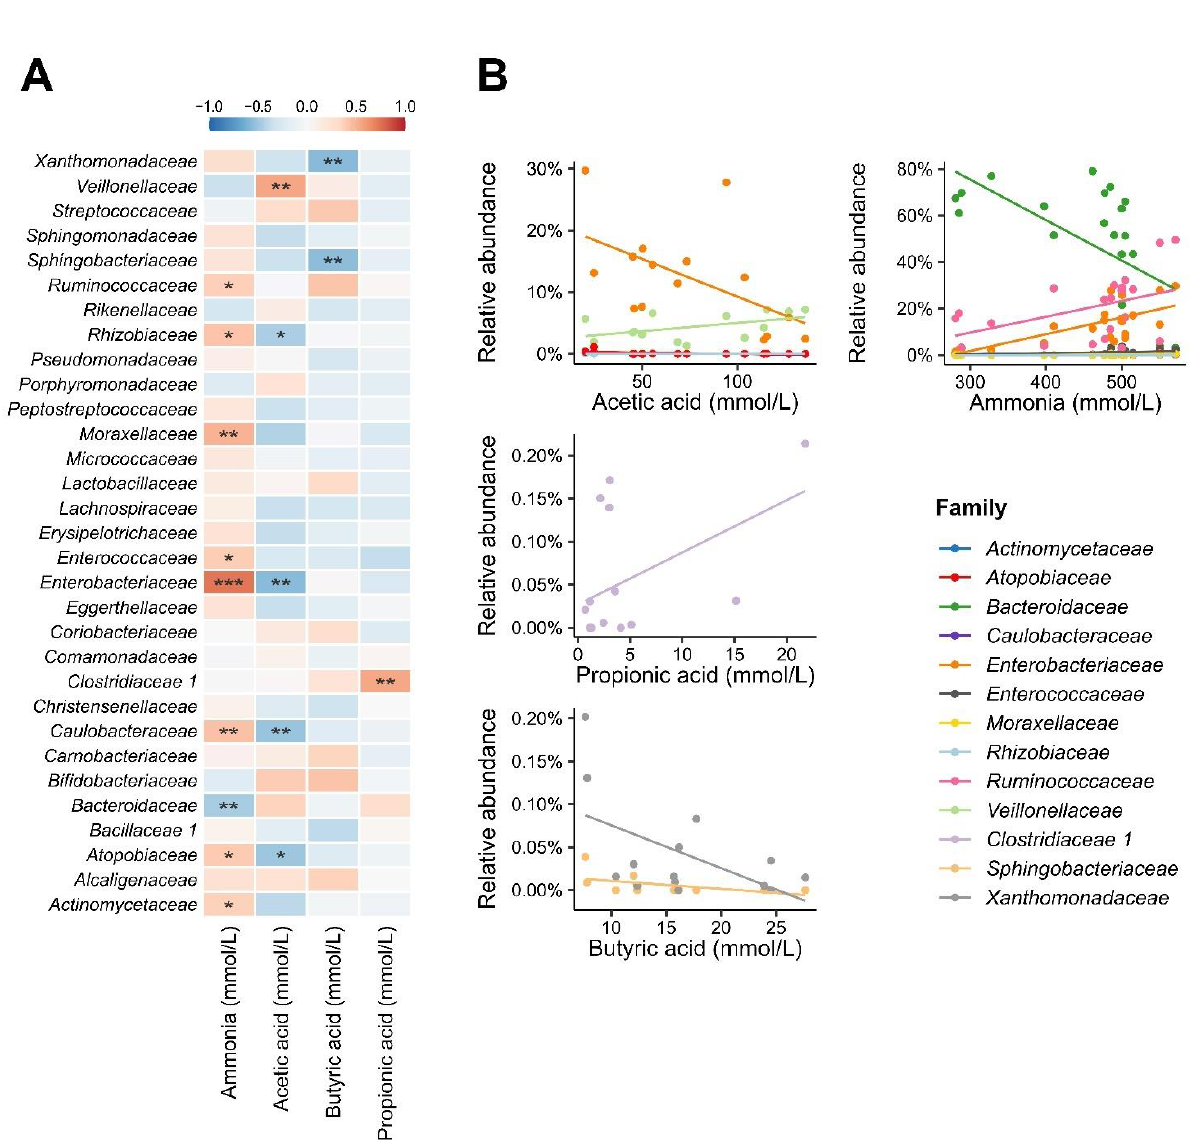
Figure 7. Correlation analysis between bacterial families and levels of ammonia and fatty acids. The heatmap ( A ) illustrates the values of the correlations in intensity and direction (positive or negative). The significance of the correlation is indicated by * ( p < 0.1), ** ( p < 0.05), *** ( p < 0.001). For families significantly correlated with the parameters evaluated, a linear regression ( B ) was obtained, demonstrating their relative abundances along the concentration gradient.